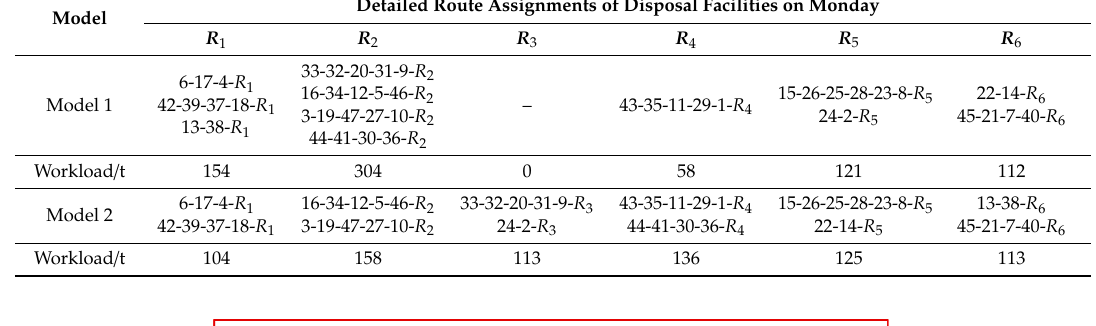
Table 14. Detailed route assignments and workload of disposal facilities on Monday in the two models. Model